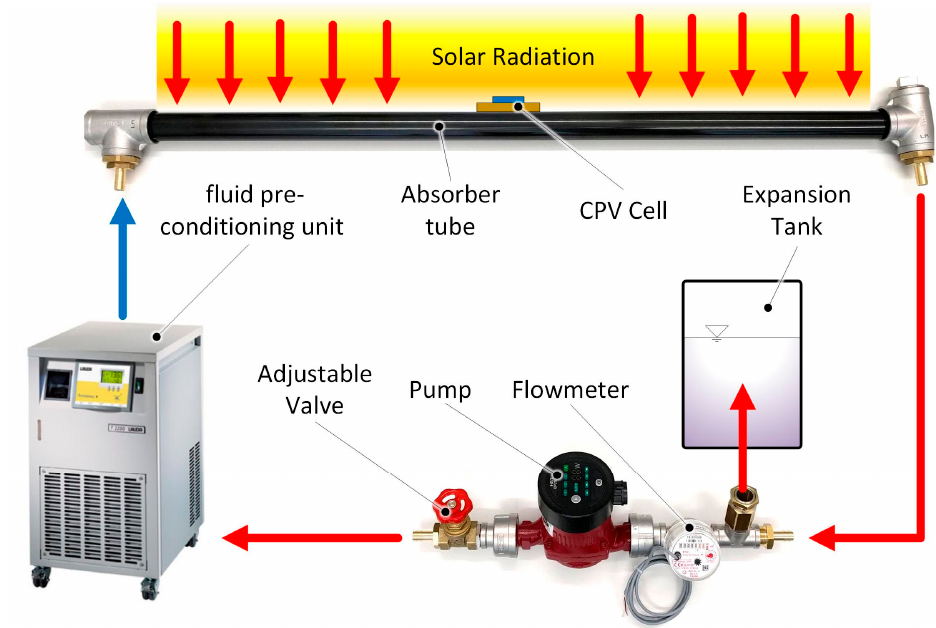
Figure 16. Schematic representation of the test setup’s hydraulic system. The temperature sensors are attached to the end caps of the absorber tube.